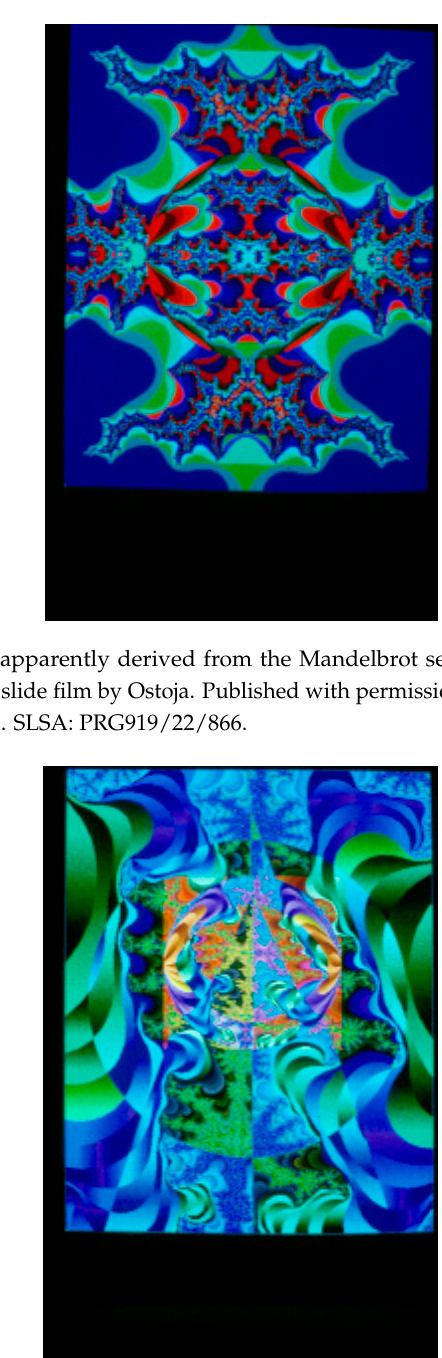
Figure 18. A screenshot, apparently derived from the Mandelbrot set, manipulated in a paintbox program, and captured on slide film by Ostoja. Published with permission. Image courtesy of the State Library of South Australia. SLSA: PRG/919/22/1271.